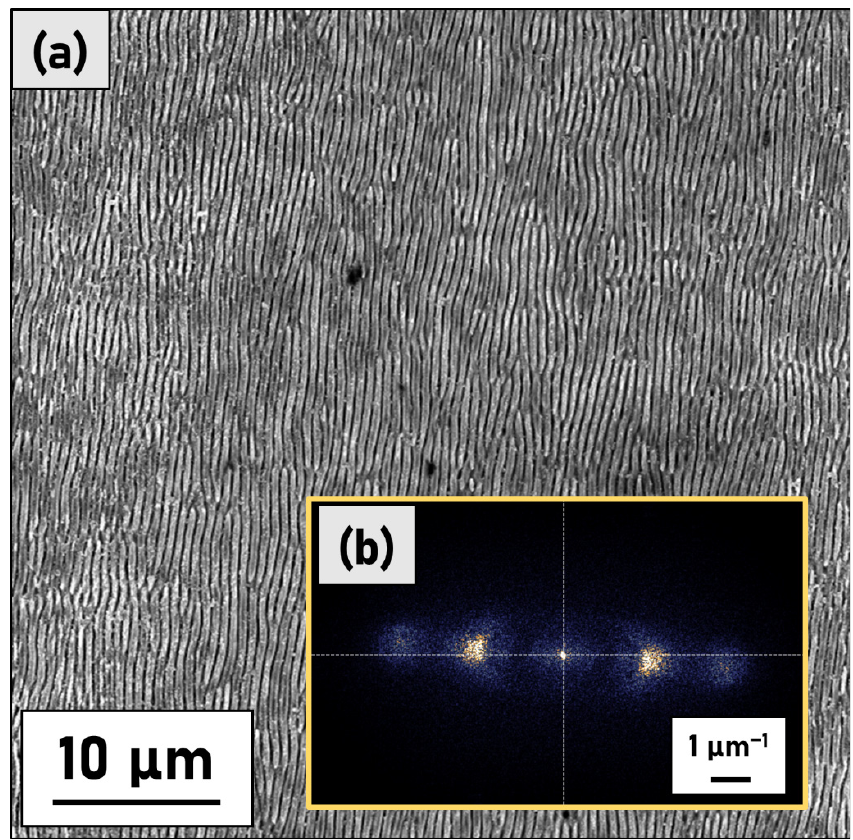
Figure 6. ( a ) Example of a large area SEM image of S1 used for the 2D-FFT evaluation. ( b ) In the inset is reported the 2D-FFT spectrum obtained by analysing the SEM micrograph shown in ( a